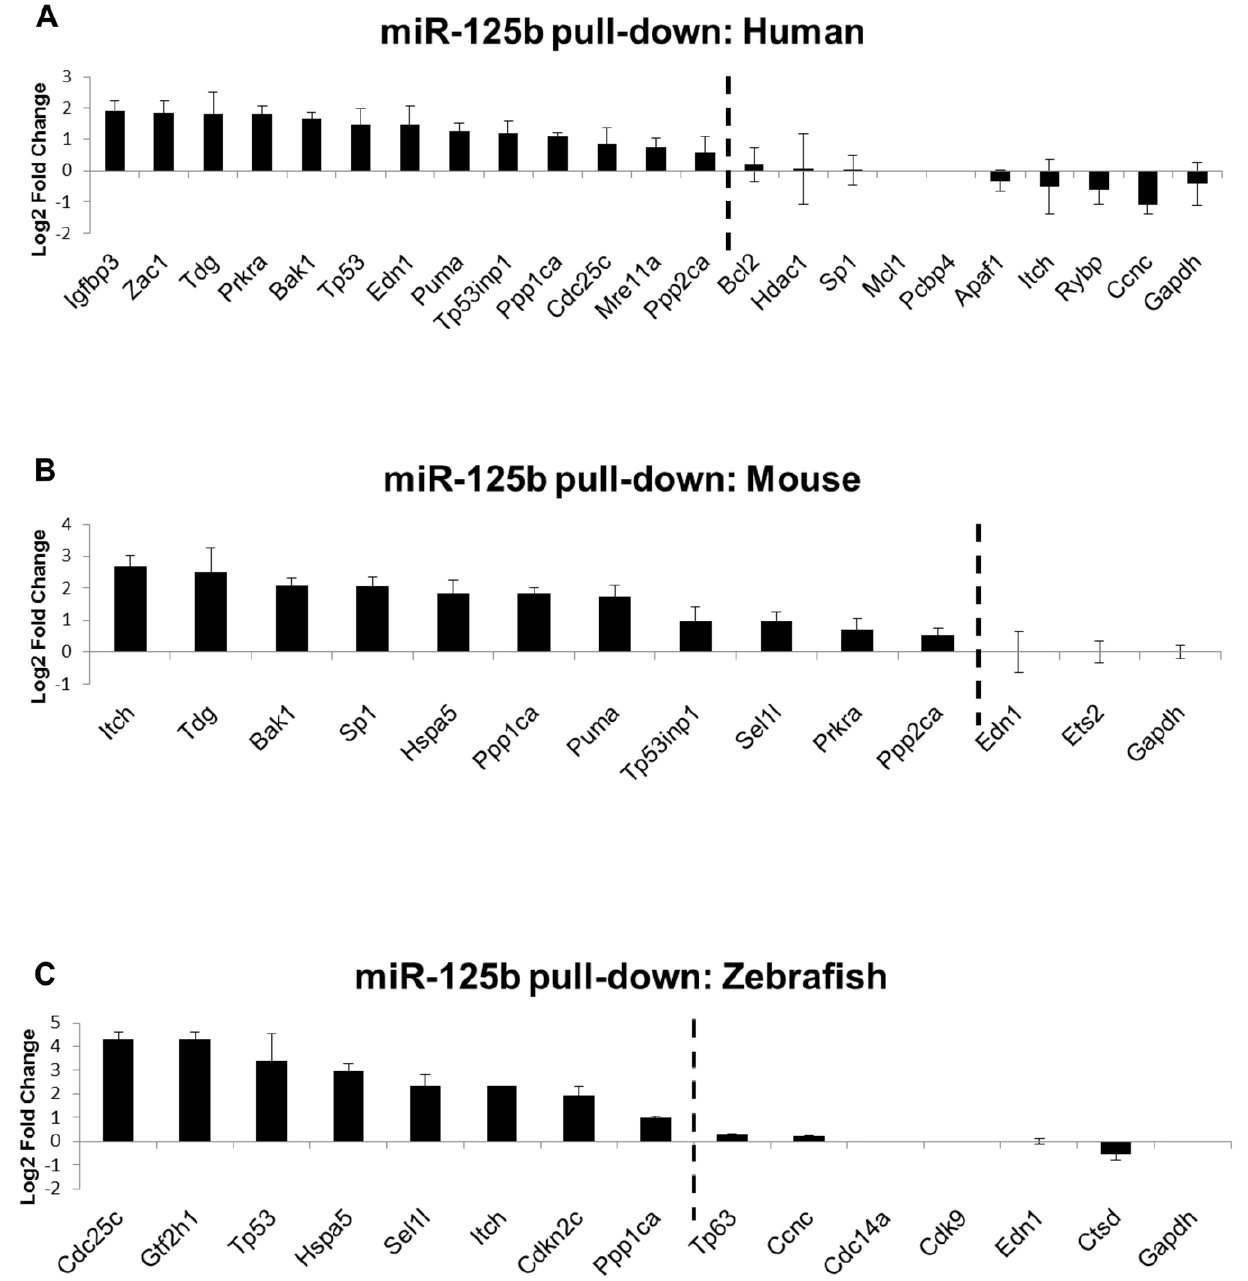
Figure 3. Direct binding of miR-125b to p53 network targets. Biotinylated miR-125b was used as bait to pull-down mRNAs bound to miR- 125b, using streptavidin-conjugated magnetic beads. The mRNAs were quantified by qRT-PCR, normalized to Gapdh, and then compared relative to the same mRNA species pulled down by a biotinylated C. elegans negative control microRNA. The enrichment of mRNAs bound to miR-125b is presented as mean log 2 fold change 6 s.e.m. (n $ 3 biological replicates). (A) Human: 13 out of 22 candidate targets were significantly enriched by miR-125b pull-down in human primary lung fibroblasts (hLF) 24 hours after transfection. (B) Mouse: 11 out of 13 candidate targets were significantly enriched by miR-125b pull-down in mouse 3T3 fibroblasts 24 hours after transfection. (C) Zebrafish: 8 of 14 candidate targets were significantly enriched by miR-125b pull-down in zebrafish embryos 24 hours after injection. Dashed line: cutoff for genes that were significantly enriched (Log 2 Fold change . 0.5, P ,